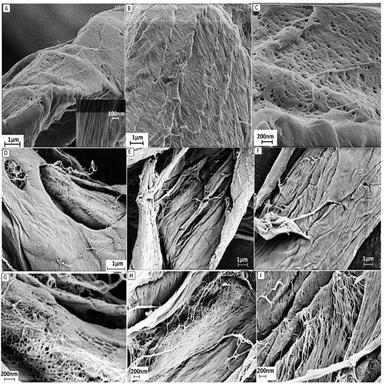
Various comparative HIM (aec) and SEM (dei) micrographs on eucalyptus never dried, critical point dried pulp: a) fiber surface that shows typical formation of fibrils throughout the surface, b,c) ultrastructure of the fiber surface at high magnification; d,g) fiber surface, the networking of nanofibrils shown; e,h) torn area of fiber, shows the internal structure of the fiber, f,i) fiber surface with some of the outer layer peeled off.